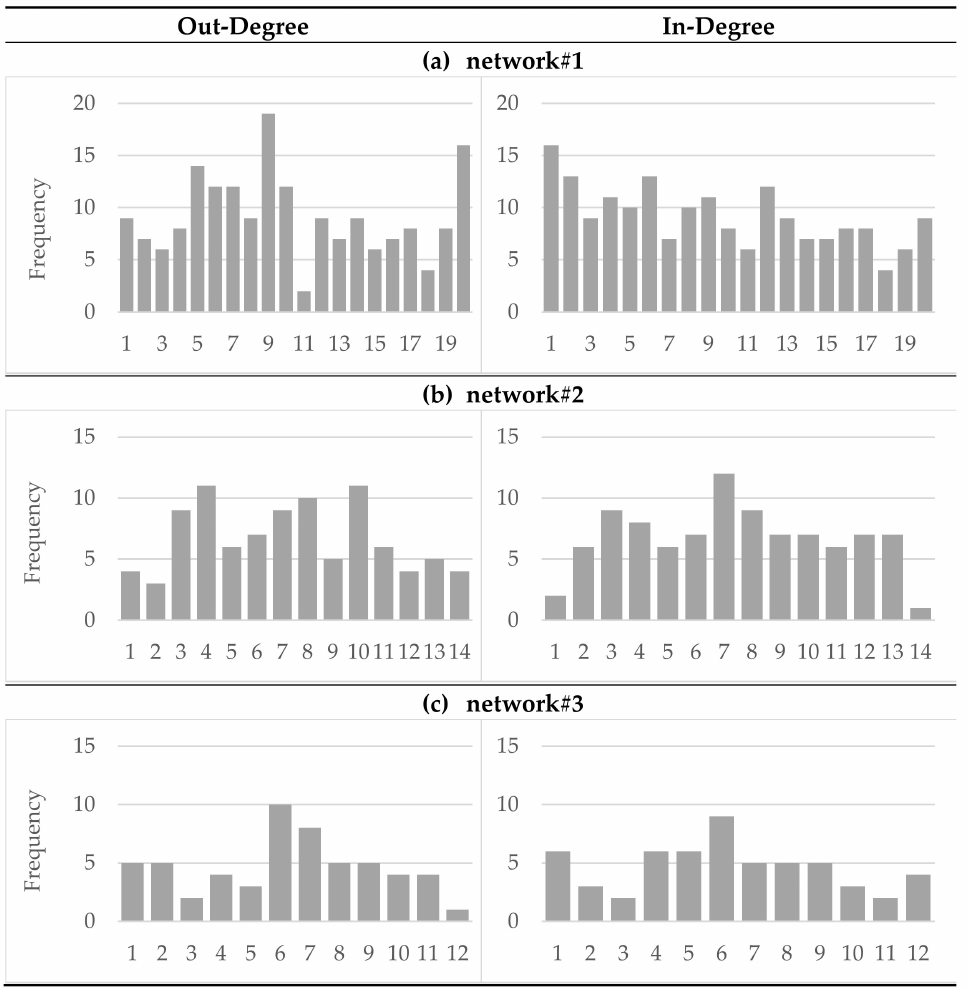
Figure 1. Degree distributions of all networks separately for ( a ) network#1, ( b ) network#2 and ( c )